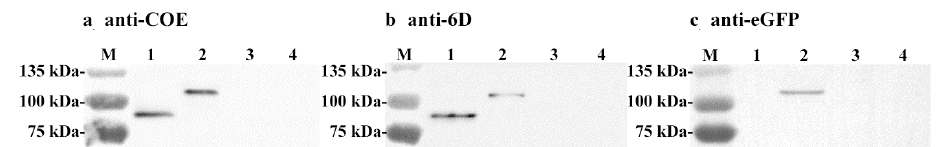
Figure 3. Western blot of recombinant Lactobacillus strain. Expression of poly- γ -glutamate synthase A (PgsA) fusion proteins by recombinant Lactobacillus was detected by Western blot with anti-COE (core neutralizing epitope) rabbit sera ( a ), anti-6D mouse sera ( b ), and anti-eGFP (enhanced green fluorescent protein) mouse antibodies ( c ). Lane 1: rLpPG-T7g10-6D-COE; lane 2: rLpPG F -T7g10-eGFP-6D-COE; lane 3: rLpPG-T7g10; lane 4: L. casei.